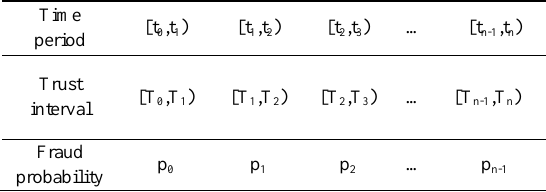
Table 1 . Trust evaluation table for the time